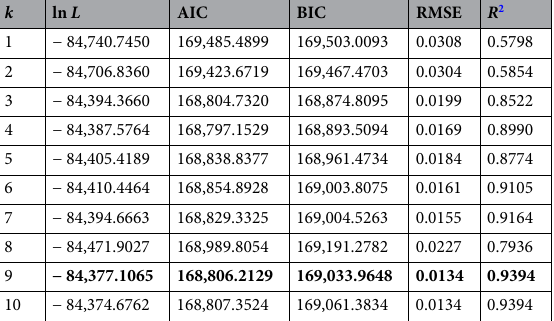
Table 5. Comparison results with different mixture model for wind direction. A voM mixture model with nine-component distributions is the optimal model. The results of the best model are in bold